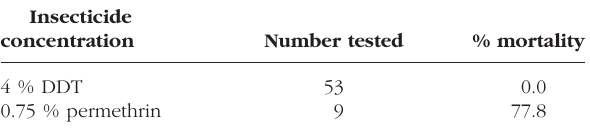
Table II. - Results of WHO diagnostic tests with F An. pharoensis raised from DDT surviving